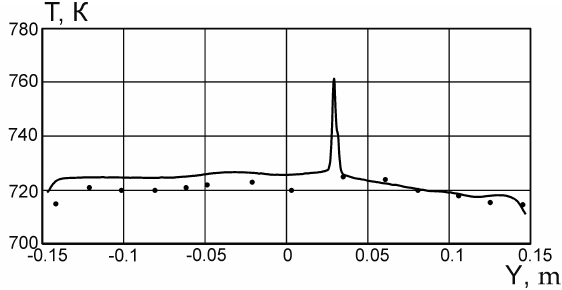
Figure 12. Graph of the temperature distribution along the Y axis ( –– calculation; • experiment).